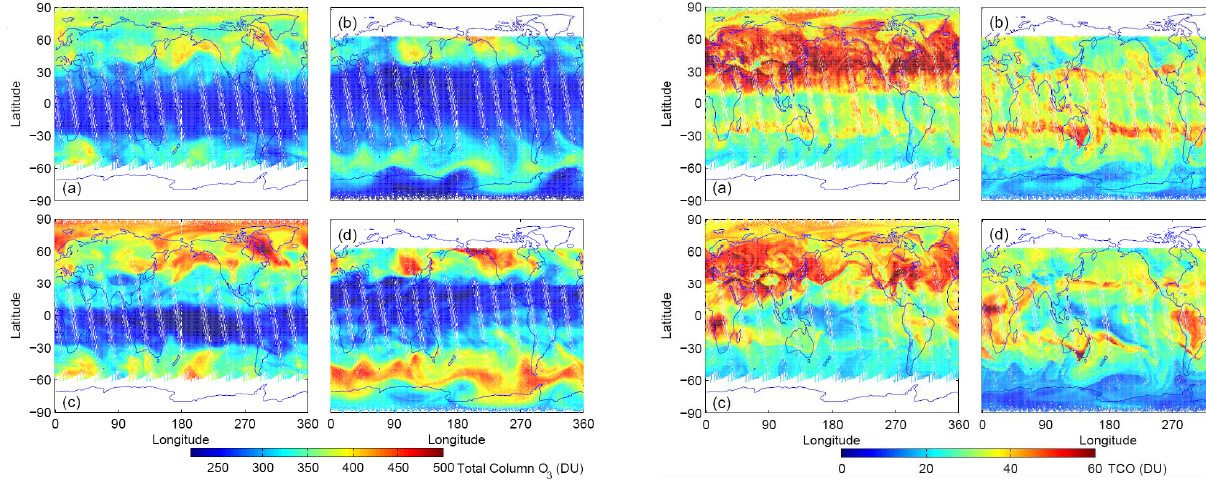
Fig. 3. Swath-by-swath comparison of total column O 3 (unit: DU) from OMI (top) and CTM (bottom) for 10 June 2005 (left) and 3 December 2005 (right).